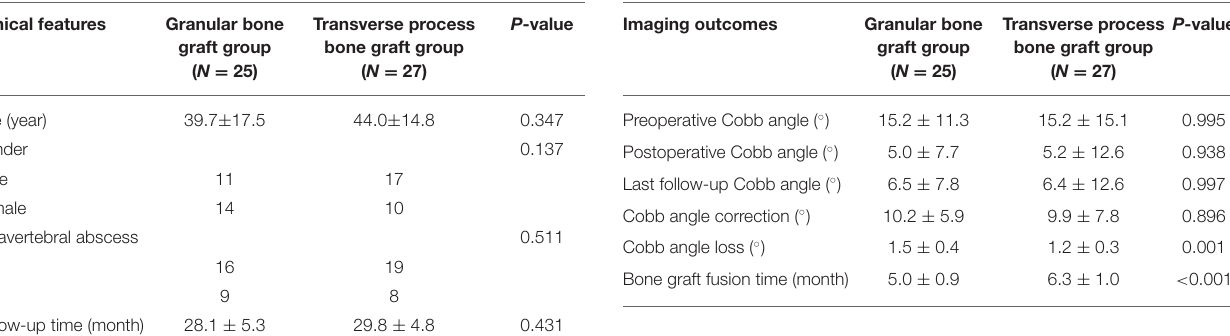
TABLE 1 | Comparison of preoperative clinical features between the two groups.